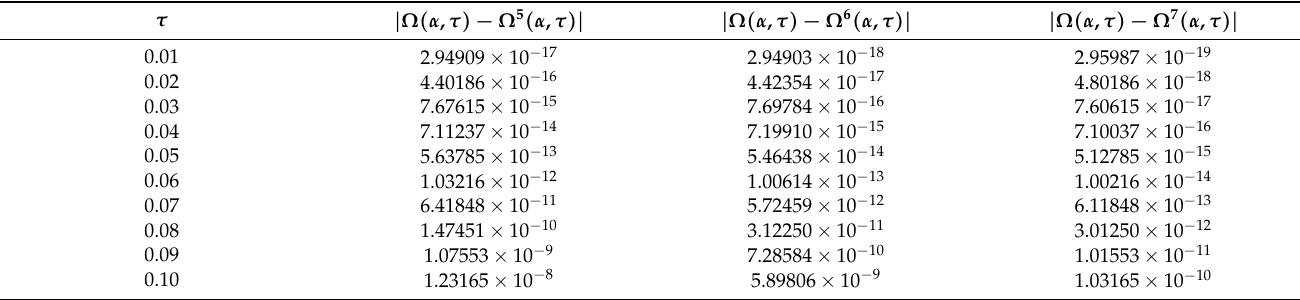
Table 11. The Abs. E of Problem 2 at α = 1.0 when ¯ h = 1.0 in the range τ ∈ [ 0, 0.10 ] .